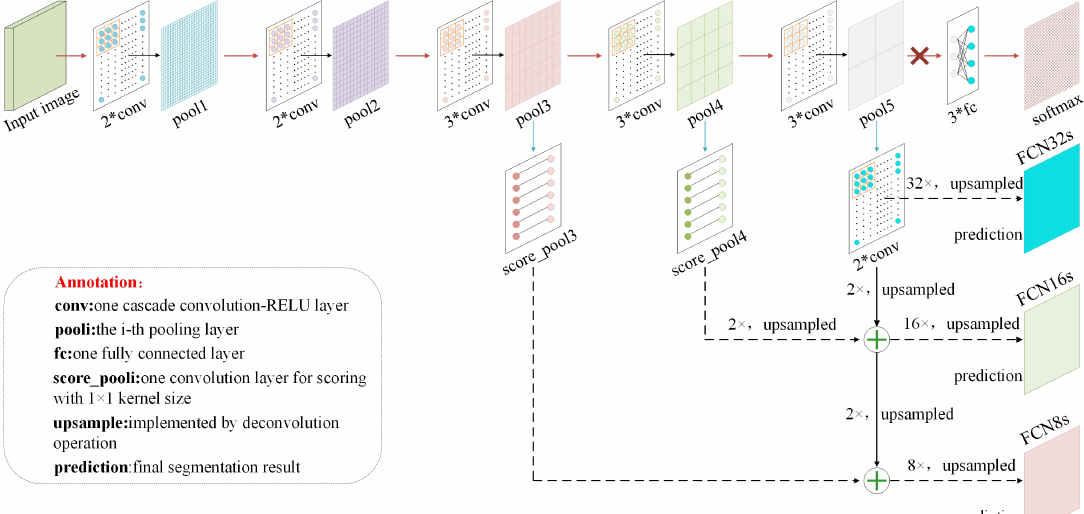
Figure 2. Architecture of Fully Convolution Network adapted from VGG-16. It can be seen that FCN8s incorporates more levels of feature maps by skip-connection. Therefore, its segmentation result is more refined and used as the segmentation backbone network in this paper.